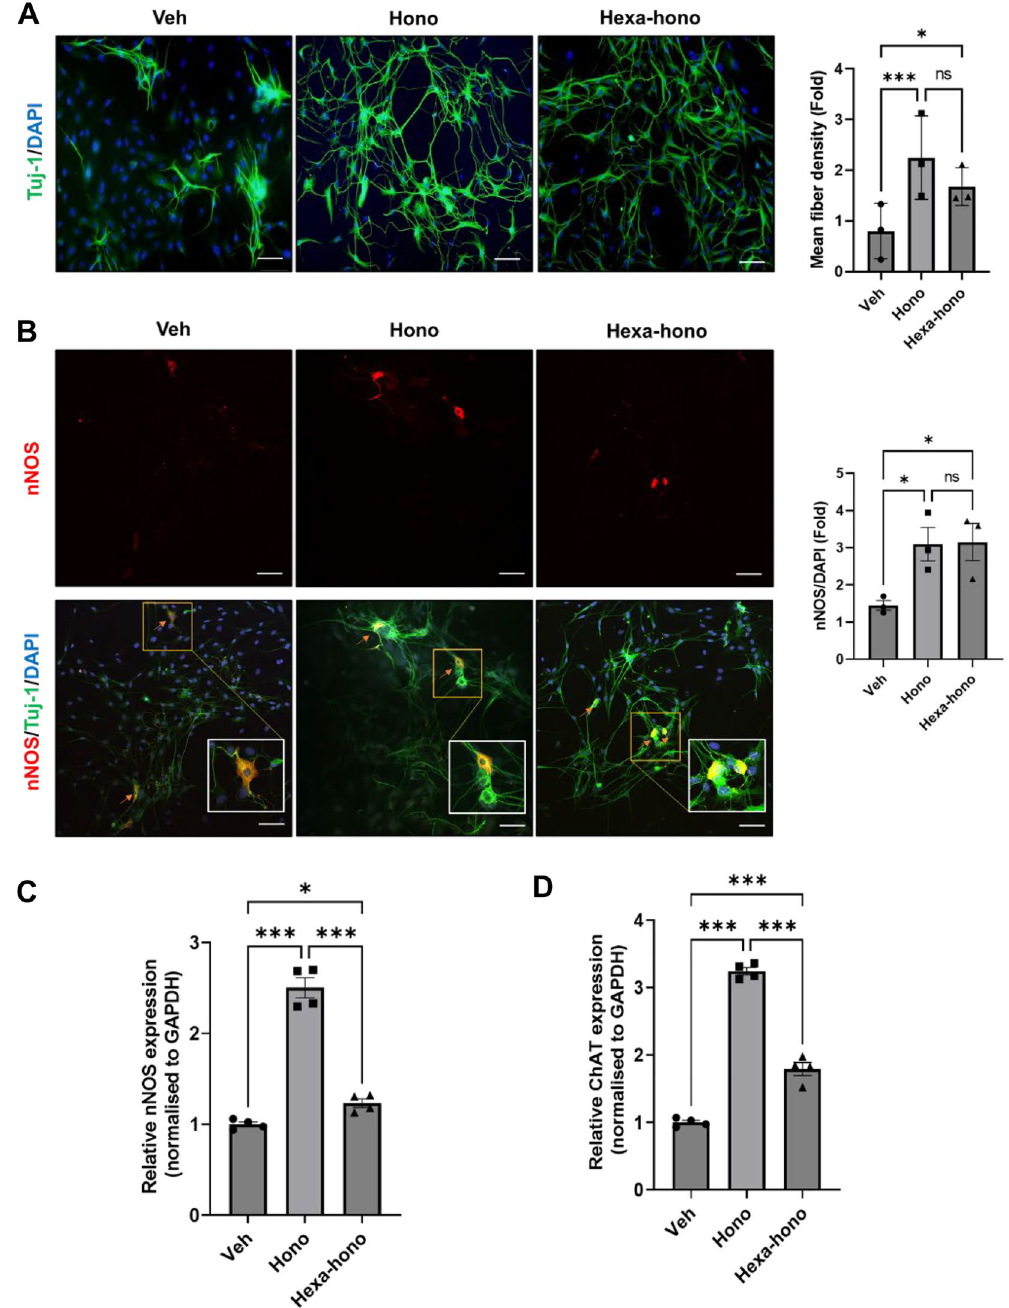
Figure 1. Honokiol and hexafluoro increase fiber density, nNOS, and ChAT neurons in primary myenteric neuronal cells ( A ) Representative fluorescent microscopy images of primary myenteric neurons treated with vehicle, Honokiol (10 μM), or Hexafluoro-honokiol (10 μM), for 24 h, and stained with neuronal marker, Tuj-1, and the nuclear stain 4,6-diamidino-2-phenylindole (DAPI). Scale bar = 50 μm. The bar graph shows the neuronal fiber density with respect to the total number of cells in each field ( B ) Representative confocal microscopy images of primary myenteric neurons stained for nNOS. Scale bar = 50 μm. The histogram represents the percentage of the number of nNOS neurons with respect to the total number of DAPI-stained cells. ( C ) Honokiol and Hexafluoro-honokiol significantly increased mRNA expression for nNOS and ChAT in primary myenteric neurons. Quantitative RT-PCR was done using primary myenteric neurons treated with vehicle, Honokiol, or Hexafluoro-honokiol for 24 h. The histograms show a fold increase with respect to the vehicle of nNOS or ( D ) ChAT expression. Data are the mean ± SEM from three independent experiments. ns = non-significant; * P < 0.05; *** P < 0.001; (2-way